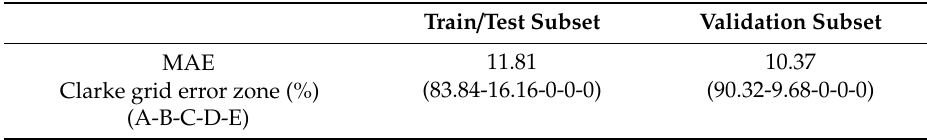
Figure 8. Clarke grid error results over ( a ) 10-fold cross-validation on the train / test sets, and ( b ) the external validation set. Table 2. MAE 1 and Clarke grid error region on train / test and validation